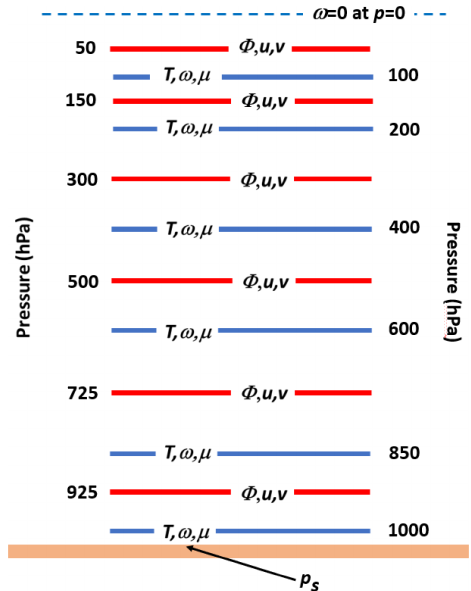
Figure 2. Vertical level structure in the six-level LAM. The vari- ables attached to each level are shown, including the geopotential ( ϕ ), the zonal wind ( u ), the meridional wind ( v ), the vertical wind in pressure coordinates ( ω ), the temperature ( T ), and the water va- por mixing ratio ( µ ). The surface pressure is also computed.